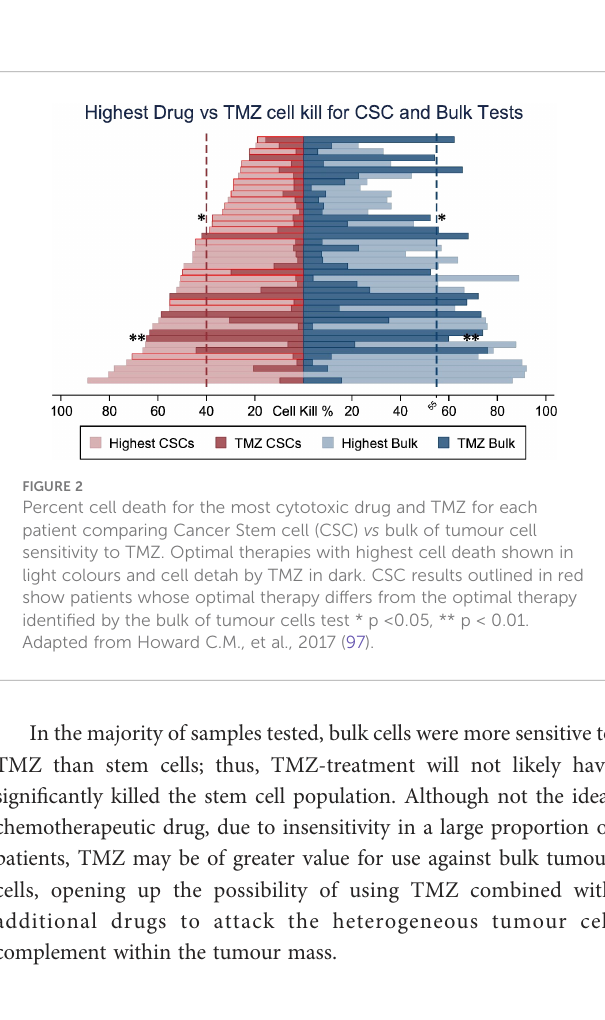
Figure 3: CUSP9 with TMZ. A , B Individually, the drugs in the CUSP9 or TMZ did not reduce cell survival, evaluated by the cell